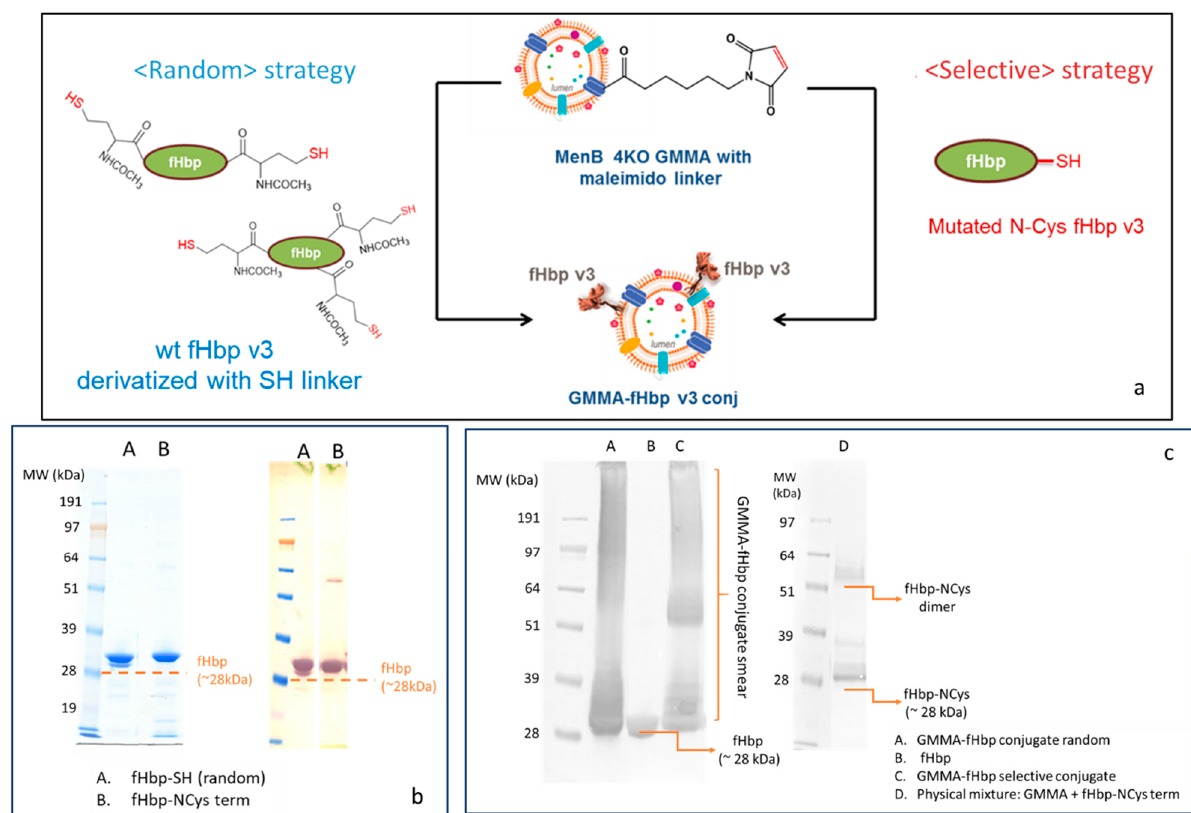
Figure 2. ( a ) Conjugation scheme for random linkage of fHbp to GMMA (fHbp derivatized with SH linker and chemically conjugated to GMMA functionalized with maleimido linker) or selective linkage of fHbp terminally mutated to have a Cys residue to GMMA-maleimido; ( b ) SDS-PAGE (left panel)/WB (right panel) analysis of fHbp randomly derivatized with -SH or terminally mutated with a Cys residue; ( c ) WB analysis of fHbp, random and selective conjugates and a physical mixture of GMMA with